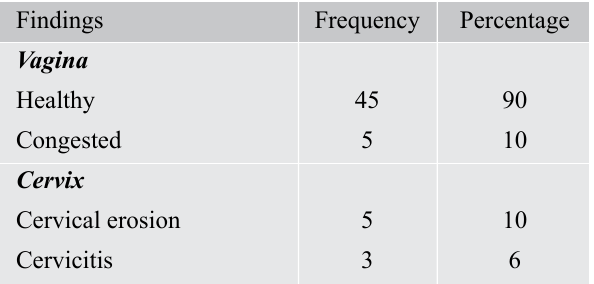
Table III: Findings of per-speculum examination of the study population